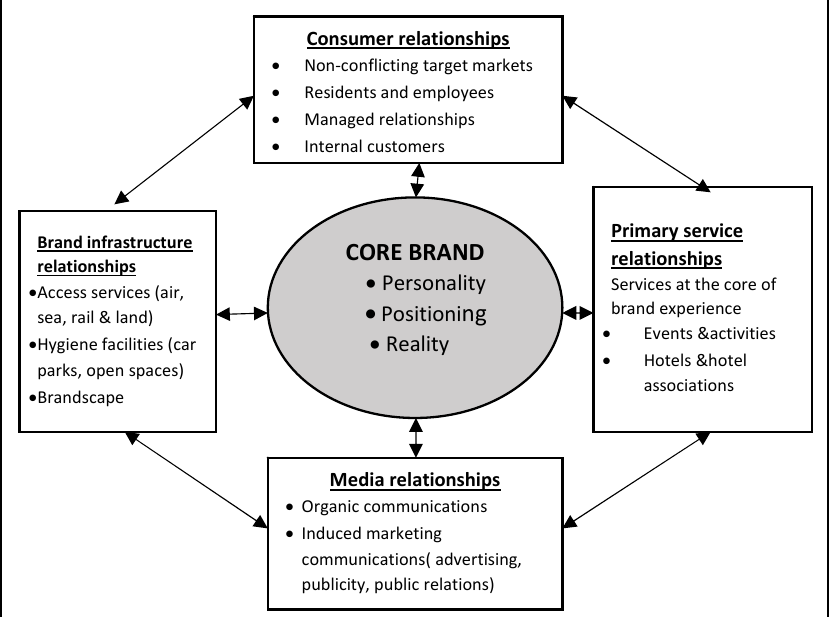
Fig. 1. The relational network brand (Hankinson, 2004